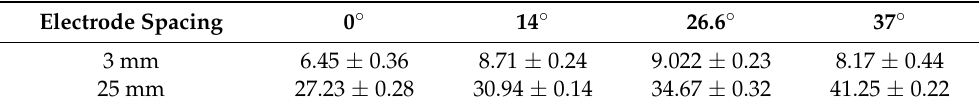
Table 4. The tongue ‐ shaped electrode APPT ablation characteristics of propellant at various electrode flare angles, the unit of m bit is microgram. m bit [ug].